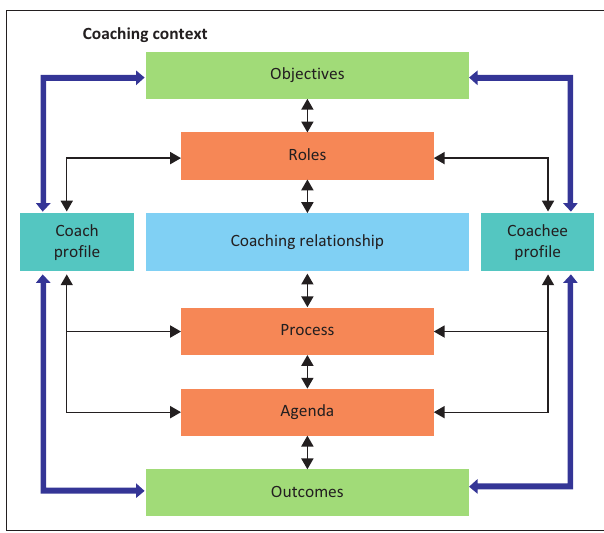
FIG URE 1: The Coaching